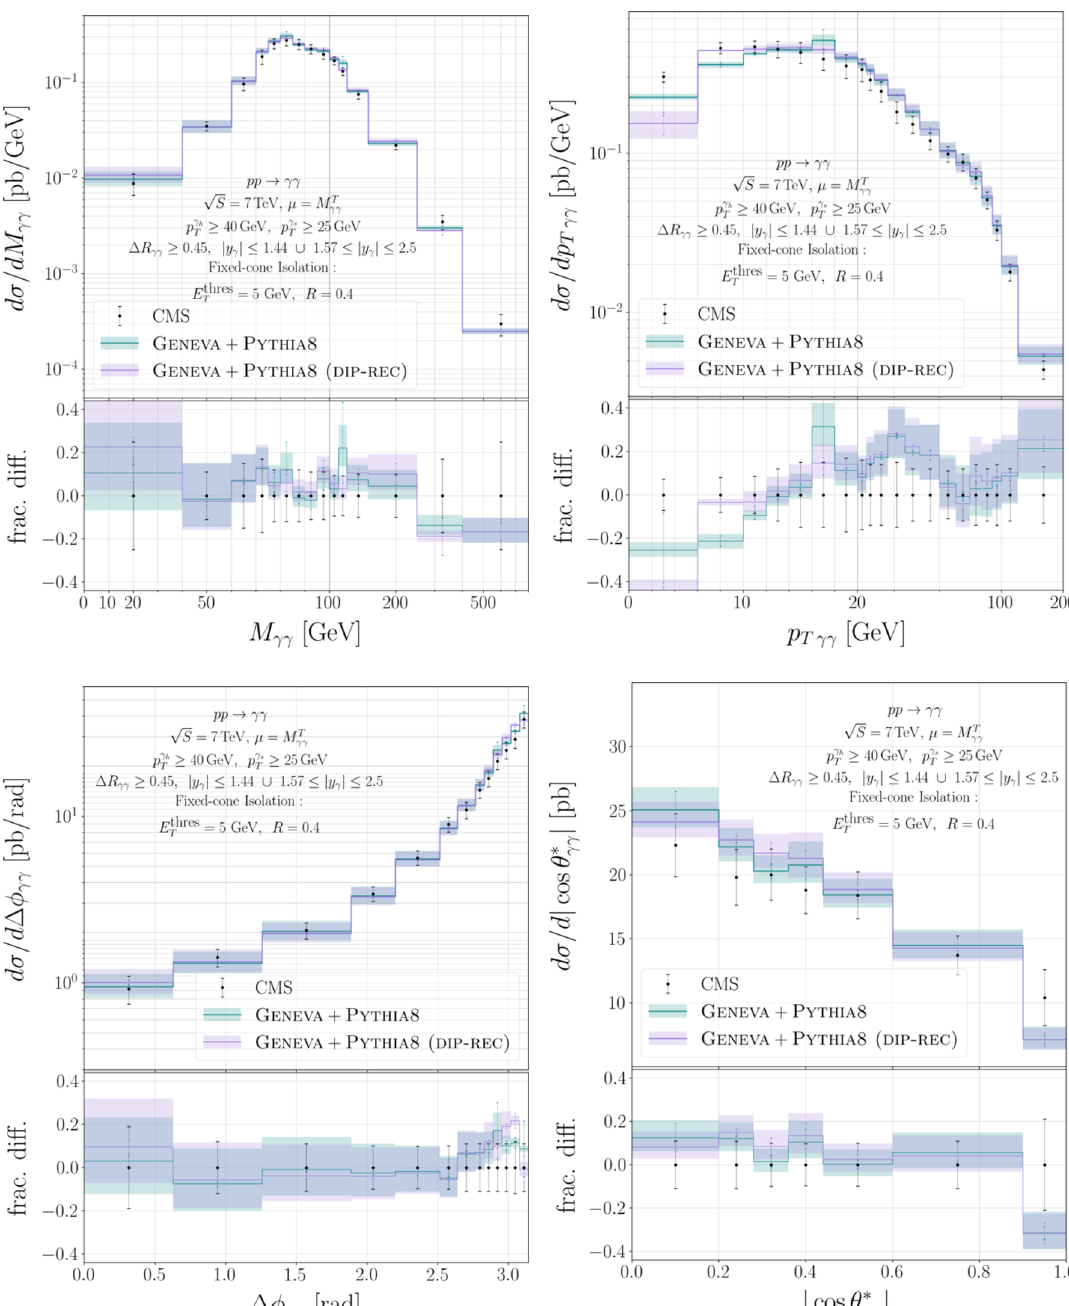
Figure 15 . Comparison between Geneva + Pythia8 and the 7 TeV data from CMS [10]. We show invariant mass of the photon pair (top left), the transverse momentum of the diphoton system (top right), the azimuthal-angle separation between the two photons (bottom left) and the cosine of the polar angle in the Collins-Soper frame of the diphoton system (bottom